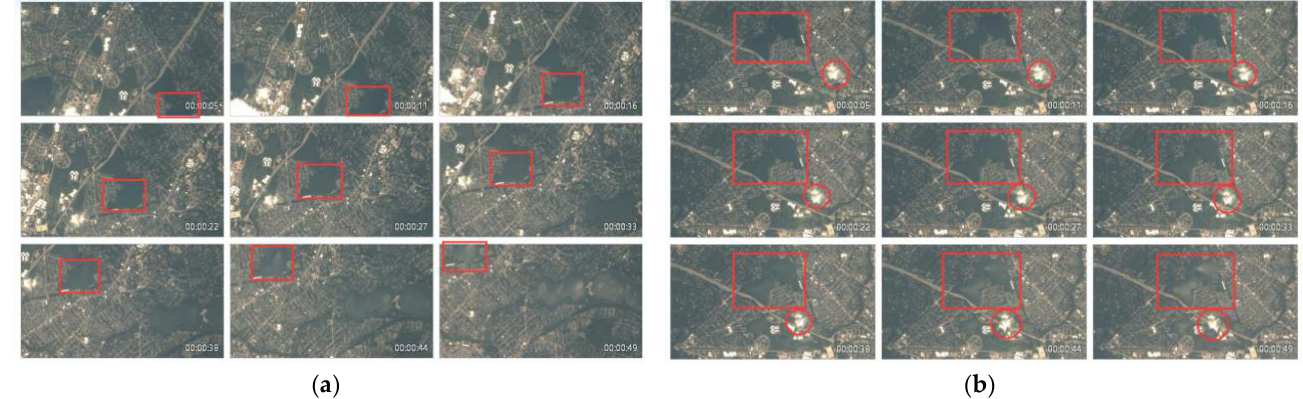
Figure 10. 1080P unstable ROI products in ( a ) and stable ROI products in ( b ).